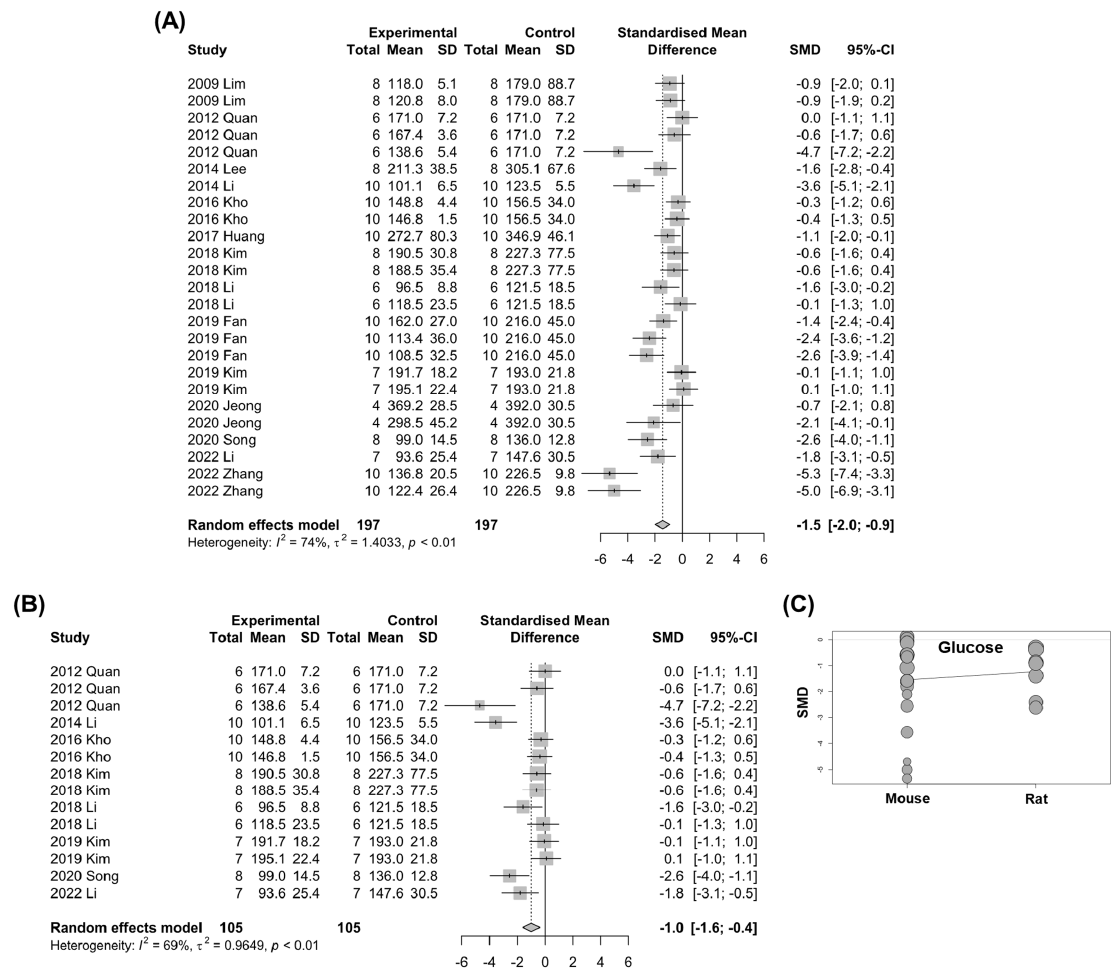
Figure 8. Effects of Panax ginseng on fasting blood glucose levels in NAFLD-induced animals. Forest plots for comparison: ( A ) All included studies [19,22,24,25,27,29,32,33,38,39,42,46,53,56]. ( B ) HFD-